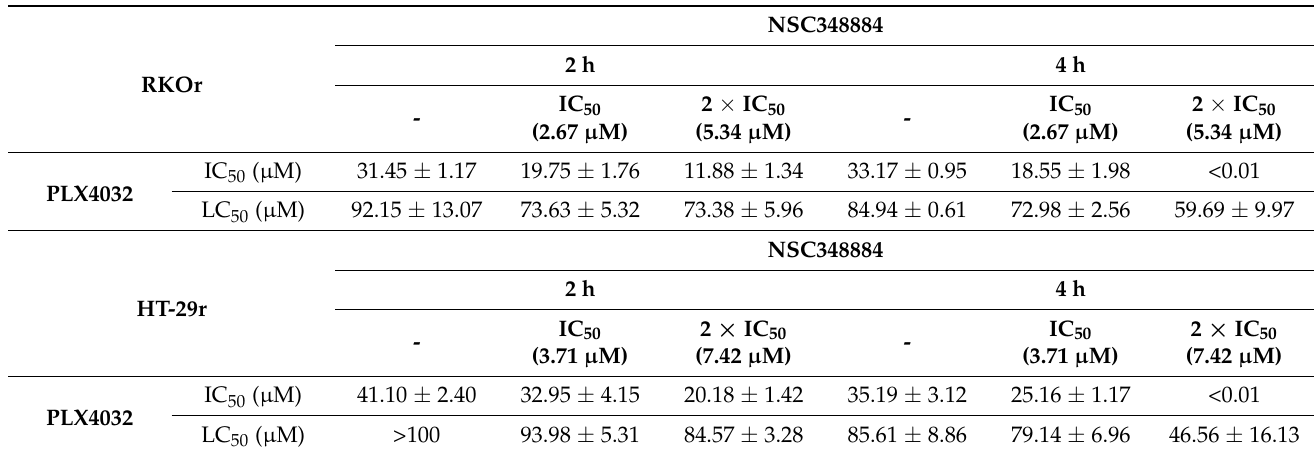
Table 5. Anti-proliferative effect of PLX4032 in BRAF mutant colon cancer cells with acquired resistance to PLX4032 after 2- and 4-h pre-treatment with cytotoxic concentrations of nucleophosmin inhibitor NSC348884 measured by the MTT assay. Shown here are the results from two independent experiments expressed as mean ± standard deviation.